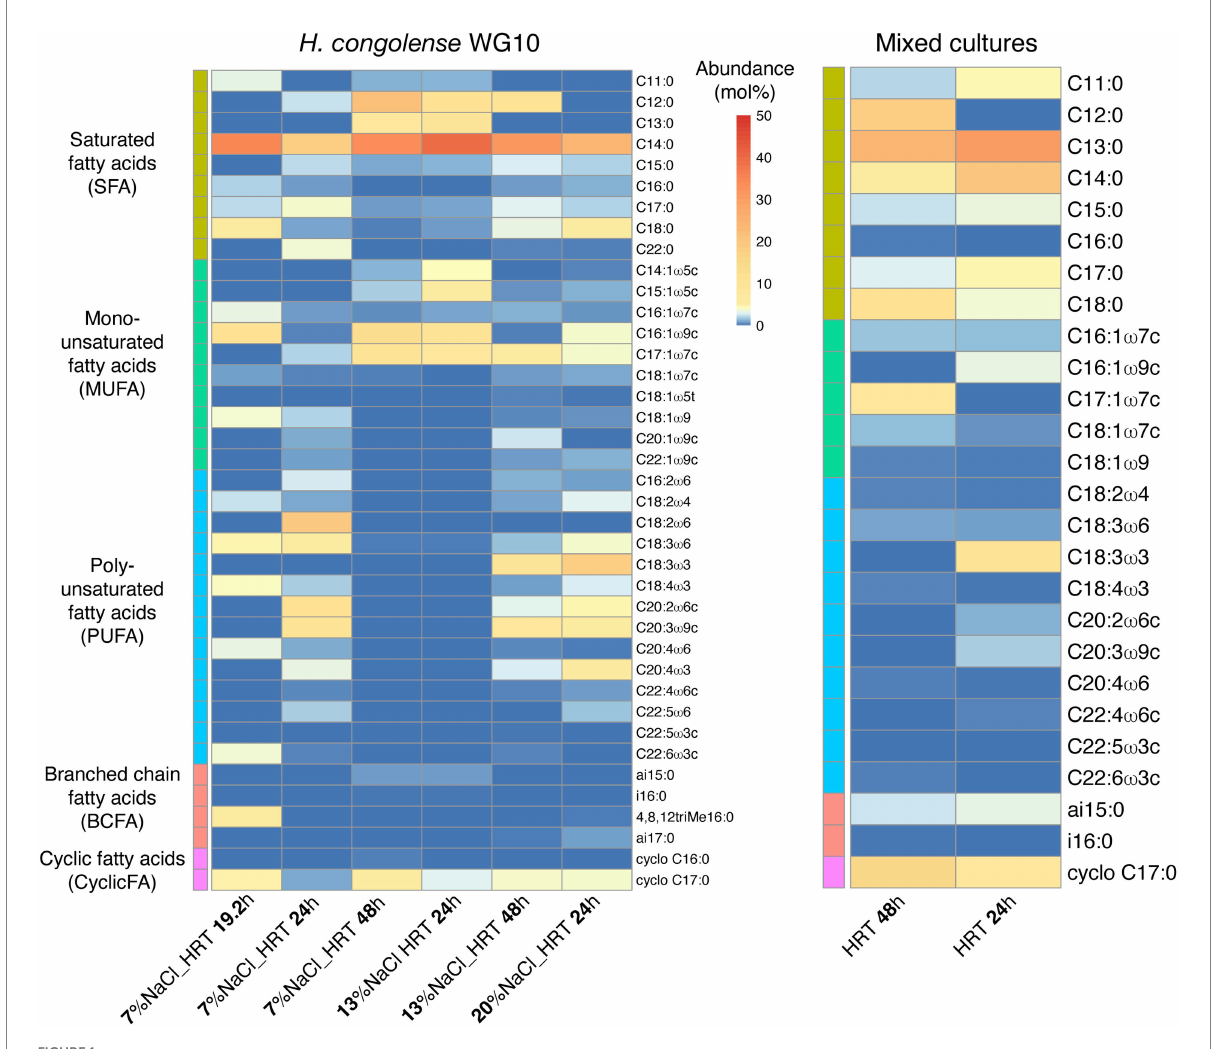
FIGURE 1 Heatmap distribution of individual phospholipid fatty acids in Halanaerobium congolense WG10 and fluid enrichment (mixed) cultures grown at 40 ° C under different salinities and HRTs. Fatty acids are sorted by class, then chain length and number of double